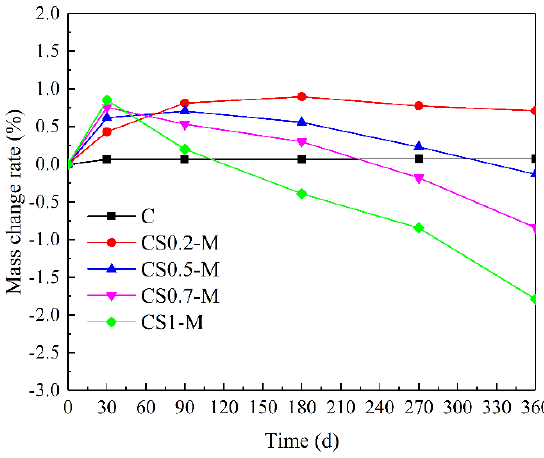
Figure 2. Changes in sample weight versus time in different solutions.